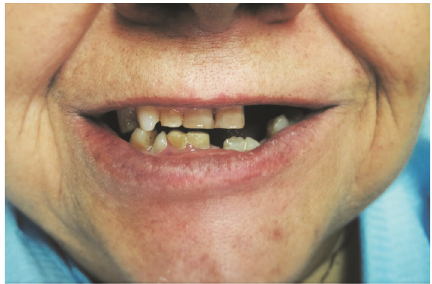
Figure 1: Initial clinical situation.